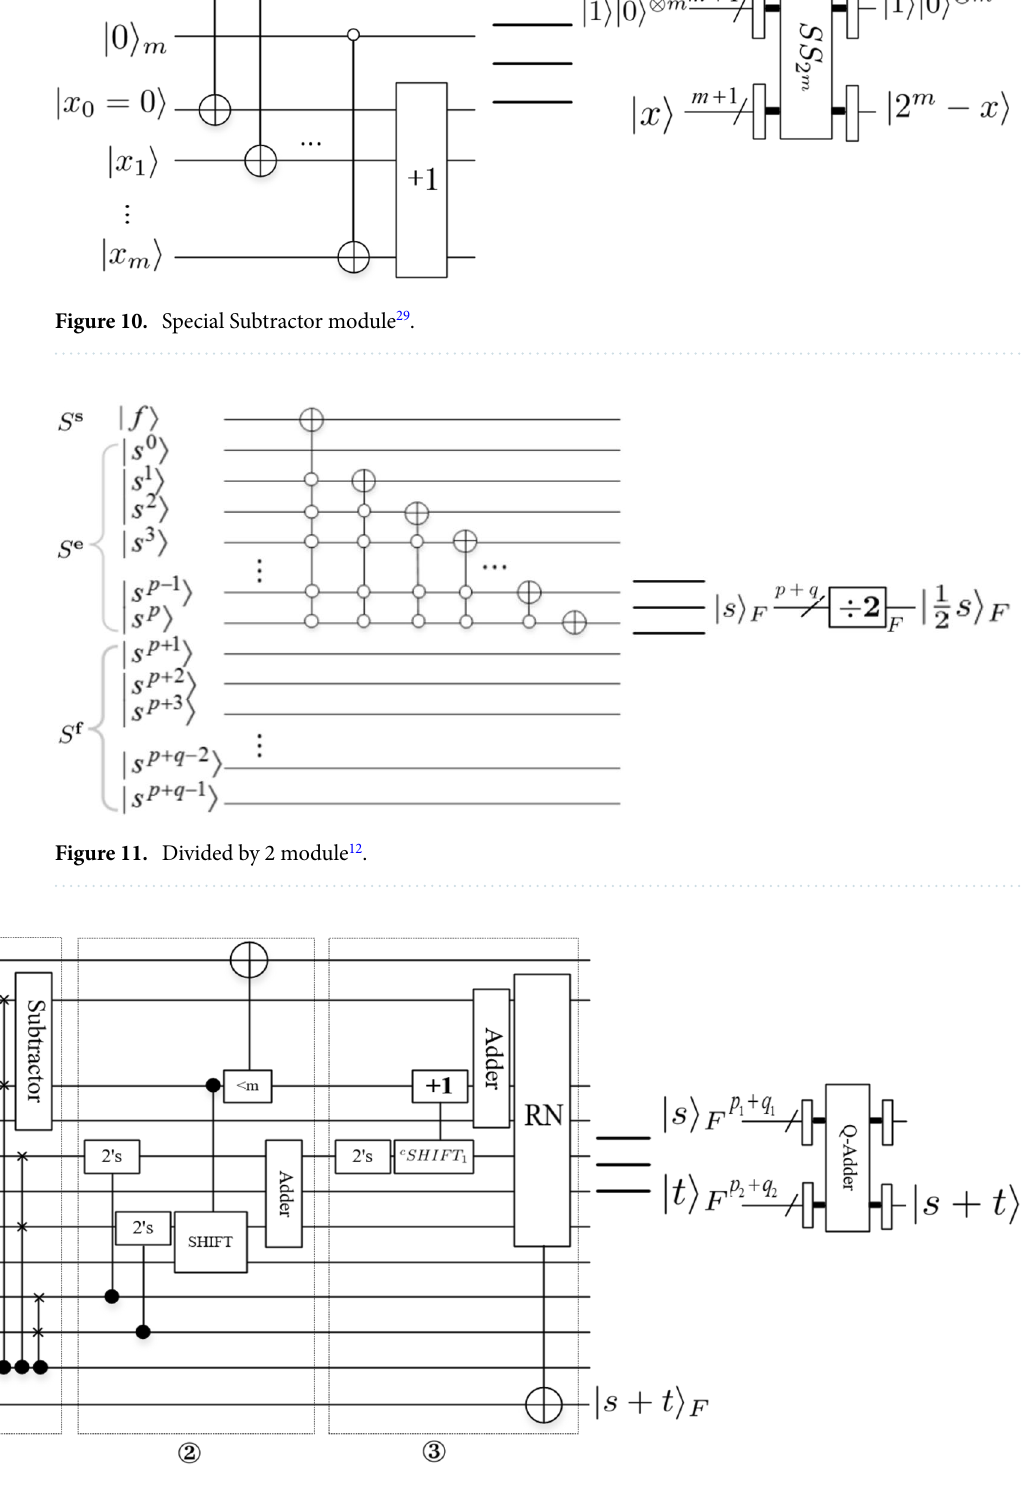
Figure 12. Q-Adder